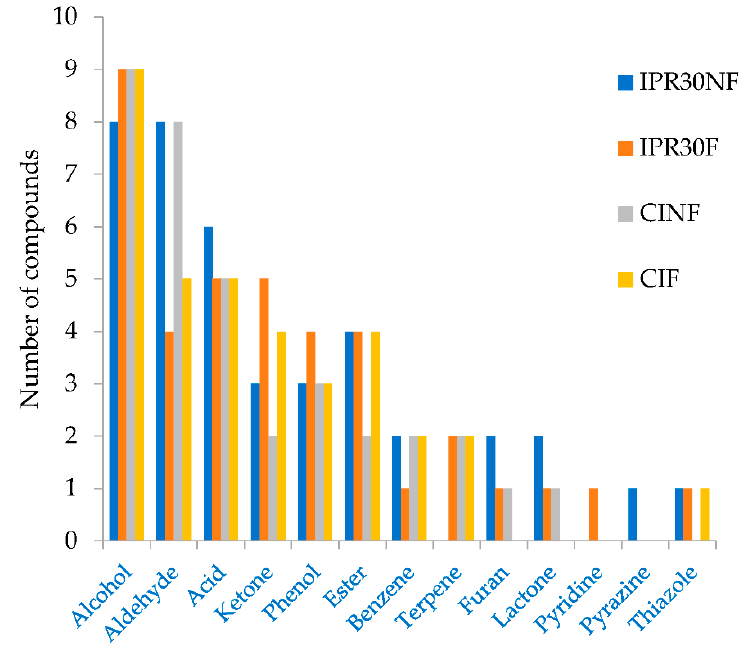
Figure 1. Groups of volatile compounds in fermented or non ‐ fermented rice brans. Inpari 30 non ‐ fermented (IPR30NF); Inpari 30 fermented (IPR30F); Cempo Ireng non fermented (CINF); and Cempo Ireng fermented (CIF).